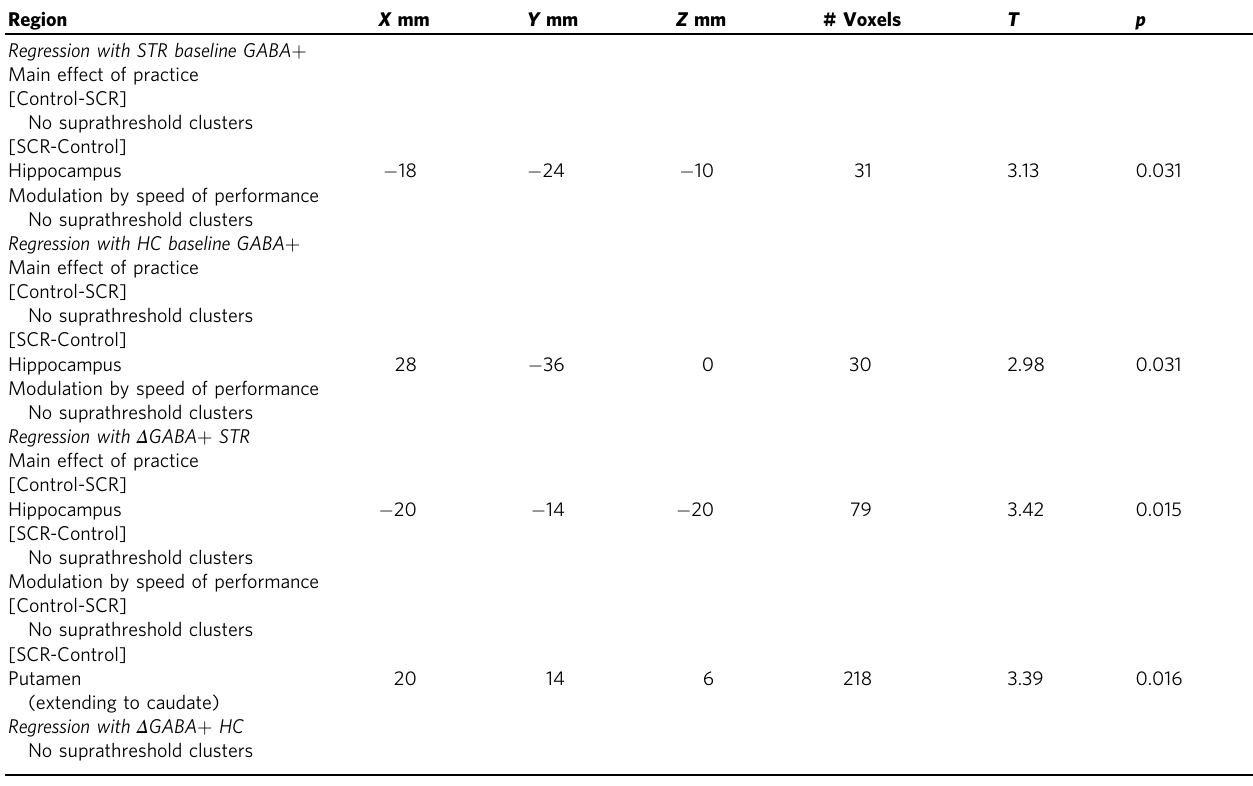
Table 2 Neuroimaging regression analyses: results of between-group comparisons.